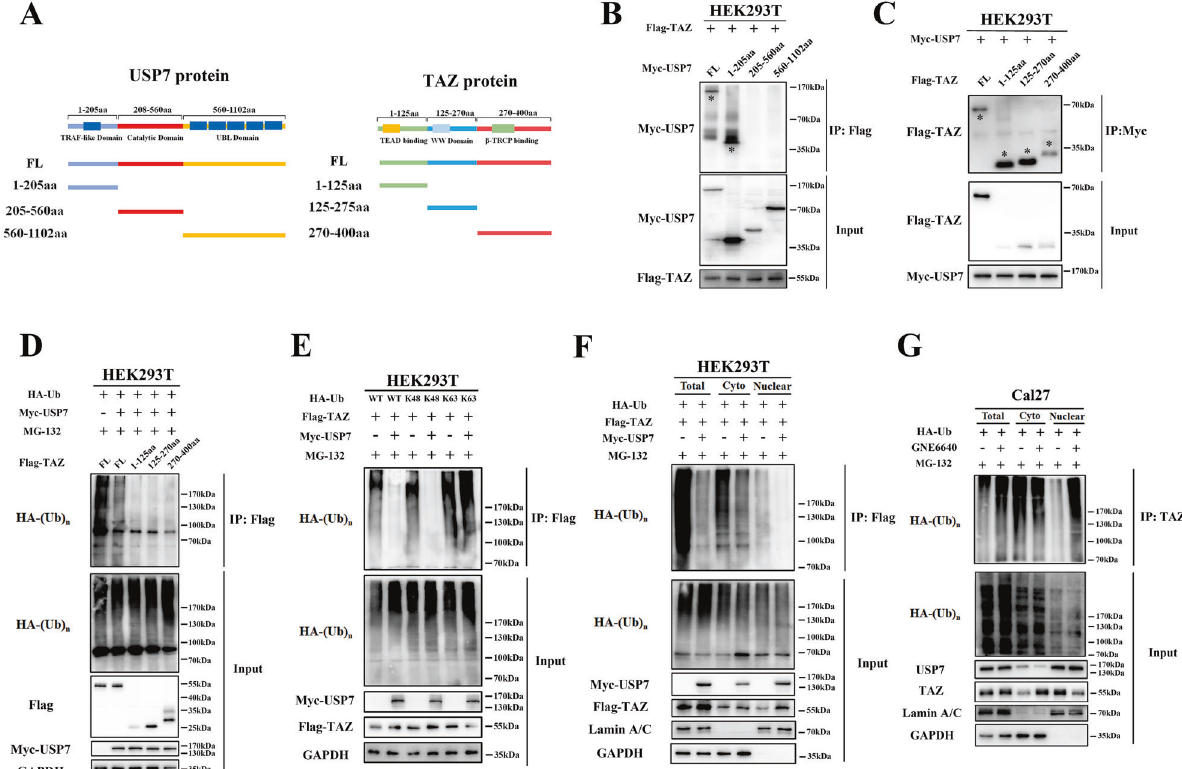
expressed in HEK293T cells. Then cell lysates were subjected to immunoprecipitation by anti-Flag antibody and immunoblotted with anti-Myc antibody. C Flag-tagged TAZ (full-length or short truncations) and Myc-USP7 plasmids were co-expressed in HEK293T cells. Then cell lysates were subjected to immunoprecipitation by anti-Myc antibody and immunoblotted with anti-Flag antibody. D The ubiquitination of Flag-TAZ or its short truncations was determined in HEK293T cells transfected with indicated plasmids. E The ubiquitination linkage of TAZ was determined in HEK293T cells transfected with indicated Flag-TAZ, Myc-USP7, and HA-Ub WT, K48-only, K63-only plasmids. F Flag-TAZ, HA-Ub with or without Myc-USP7 plasmids were co-transfected into HEK293 cells. After 48 h, the whole lysates and subcellular fractions (cytoplasmic were subjected to immunoprecipitation by anti-TAZ antibody and immunoblotted with anti-HA antibody. Data were presented with representative images from three independent